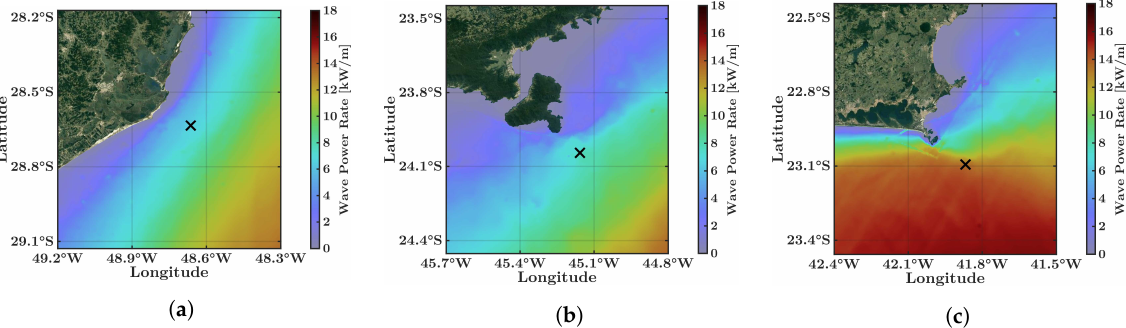
Figure 10. Standard deviation of wave power rate P w (kW/m) over the 18 years simulated. The “X” marks the position where the time series were extracted for the wavelet analysis in Section 3.3: ( a ) Laguna; ( b ) Ilhabela; and ( c ) Farol